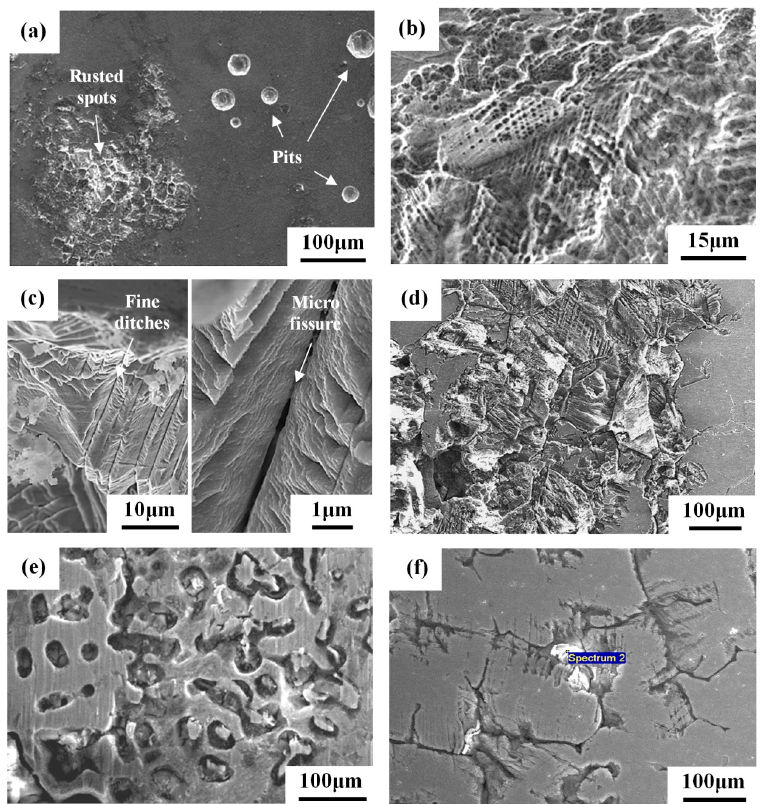
Figure 7. SEM micrographs showing the surface morphologies of weight-loss specimens: ( a ) 304L-BM; ( b , c ) 304L-CR; ( d ) 304L-CRS; ( e ) 308L-AW; and ( f ) 308L-CR specimens. With the applied five percent strain in the U-bend specimens, the occurrence of deformation would introduce slip bands into the 304L-BM and 308L-AW specimens. A small sample was cut from the U-bend specimen and subjected to metallographic preparation for further inspection of the SCC cracks. Figure 8 shows the superficial crack path of the U-bend specimens after salt spray. The slip bands of the 304L-BM specimen assisted the formation of oriented microvoids (Figure 8a). The linking of microvoids in the 304L-BM specimen was expected to turn into microcracks if the testing interval had been prolonged. For the 304L-CR specimen, cracks initiated at the slip bands and might propagate parallel or transverse to the slip bands (Figure 8b). Stepwise crack growth was seen in the prior work studying the SCC of 304L in the salt-spray environment [6]. In the case of the 304L-CRS specimen, the cracks tended to initiate at the slip band and then might propagate along the prior austenite grain boundaries (Figure 8c). Furthermore, corrosion pits at the grain boundaries were more likely to be seen in the 304L-CRS specimen. Intergranular corrosion seemed to promote